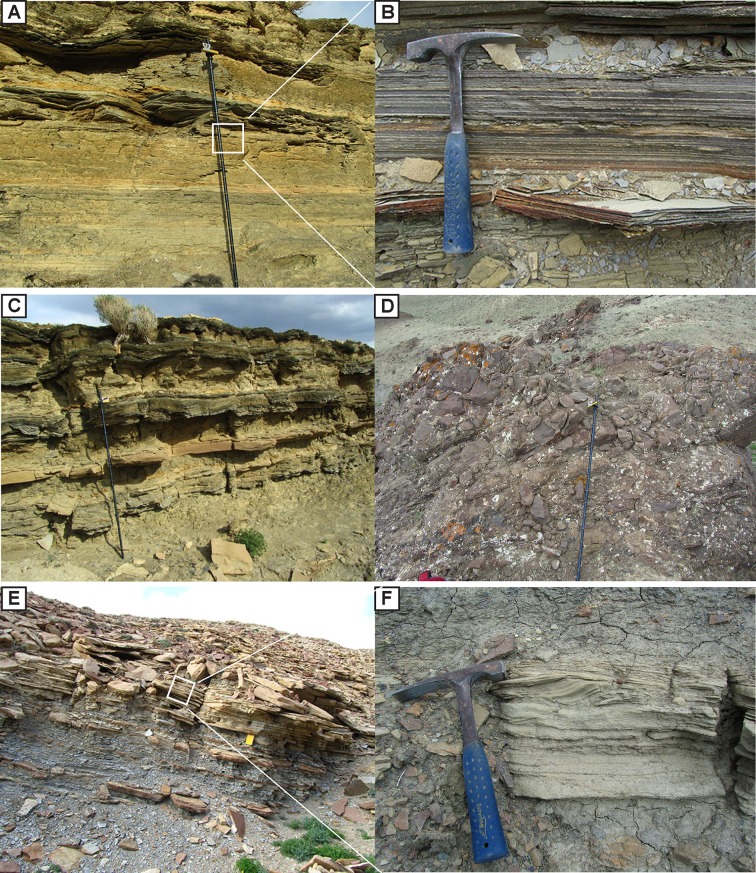
Photos of the main facies.(A) Laminated mudstone facies of the lower interval. (B) Close view of organic-rich, laminated mudstone. (C) Interbedded mudstone, tabular sandstone, siltstone, and marl facies. (D) Pillow lava of the lower interval. (E) Coarsening upward interbedded sandstone, siltstone, and mudstone facies within the upper interval. (F) Climbing ripples of the sandstone facies within the upper interval.